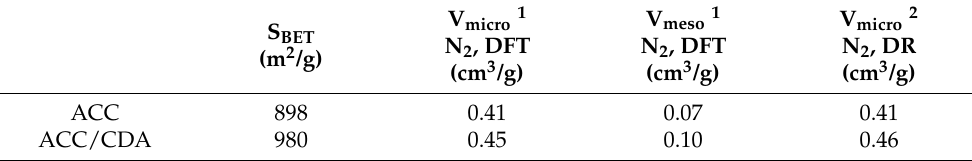
Table 3. Textural characteristics of ACC (FM50K) and ACC/CDA materials analyzed by N 2 adsorp- tion at 77 K.